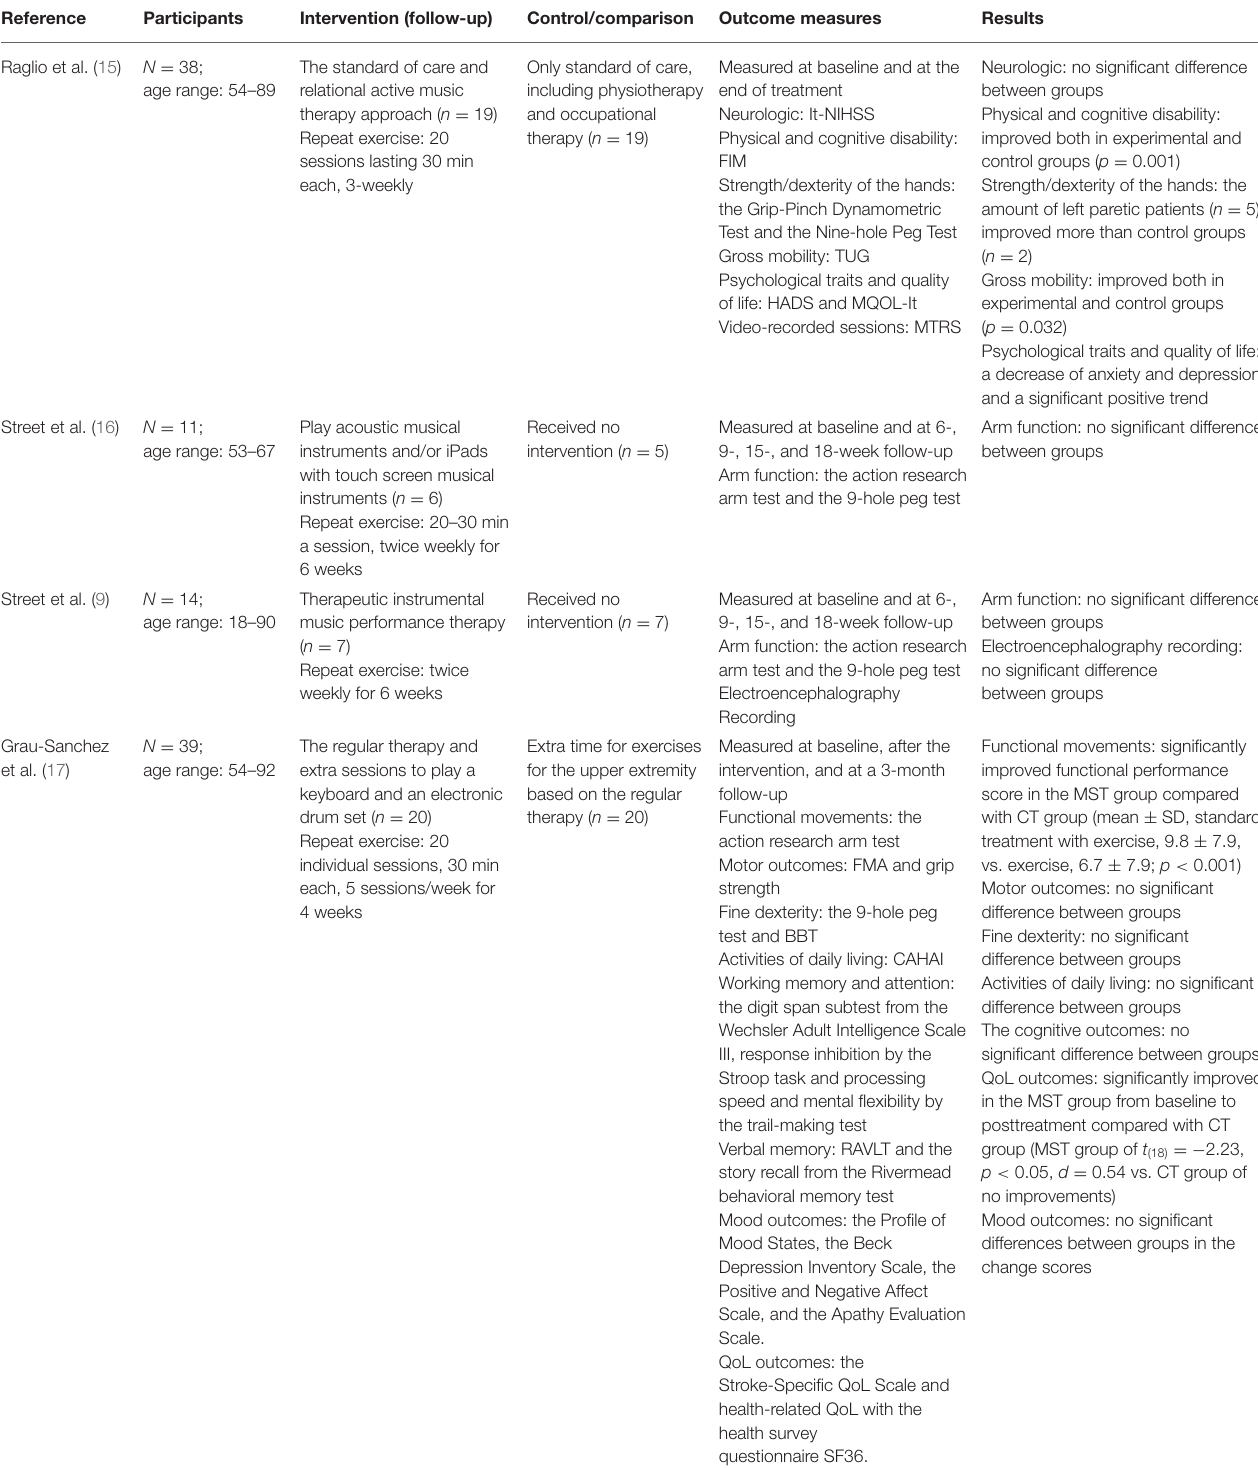
TABLE 1 | Summary of the included studies and the detail of intervention and measurement.